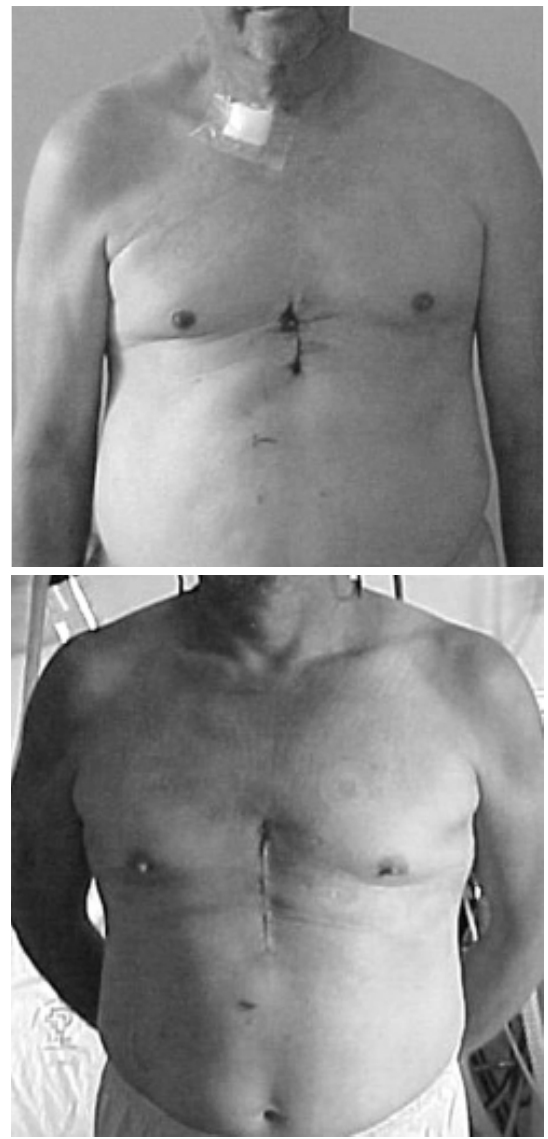
Fig. 3 - Aspecto final da incisão